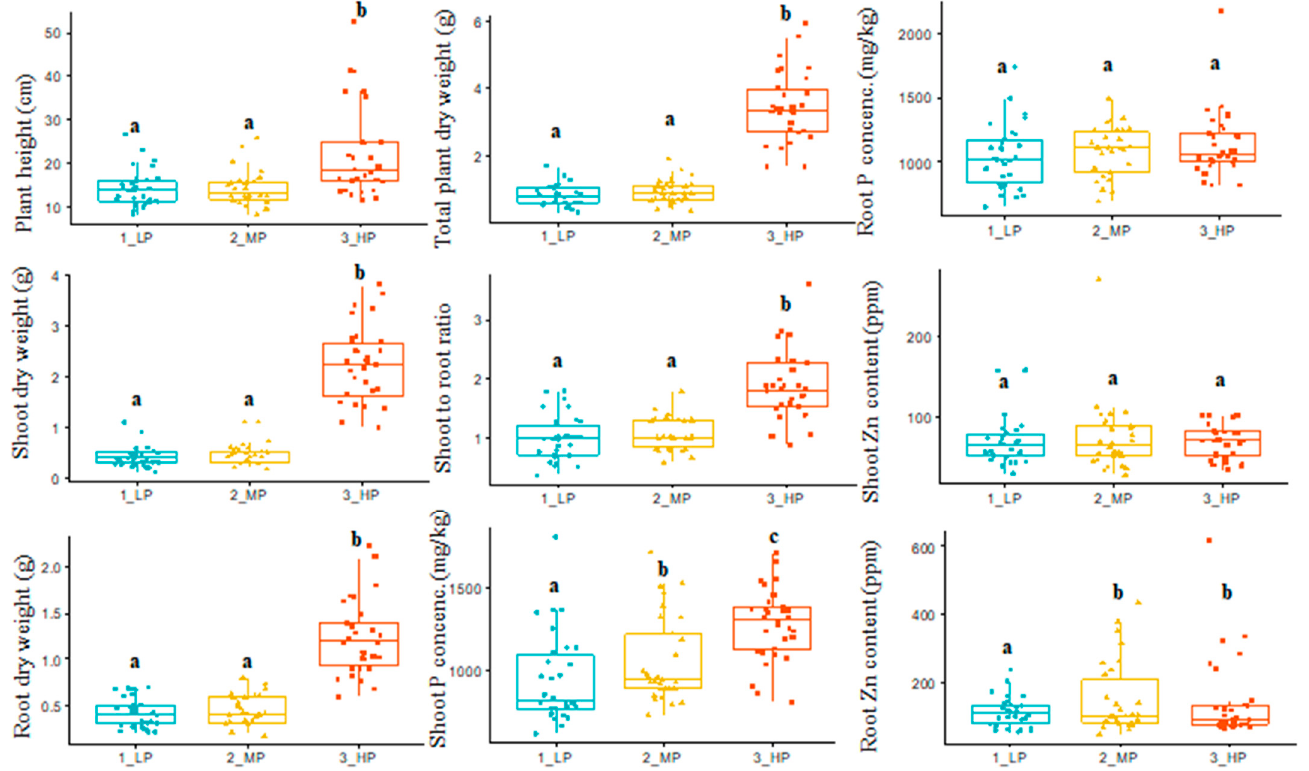
Figure 1. Phenotypic distribution of traits measured in the screenhouse under varying soil phosphorus levels. Box plot displays the median of each group bounded by the first and third quartile, where the X -axis is soil phosphorus concentrations. 1_LP = no-P application, 2_MP = 1.5 mg P kg − 1 , and 3_HP = 30 mg P kg − 1 added to Hoagland nutrient solution used for watering the plants. Letters above each box plot denote similarity among groups as per Tukey’s honestly significant difference comparison test ( α ≤ 0.05). Means with the same letter are not significantly different.